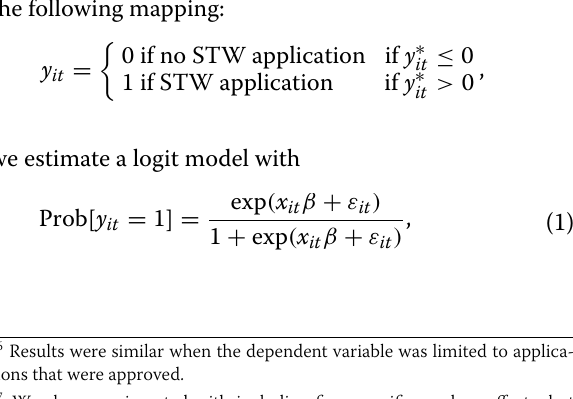
Data refer to the end of 2013 (unless otherwise stated). Aggregate statistics are weighted to be representative of the number of employees in the target firm population. Shares may not add up to 100% due to rounding